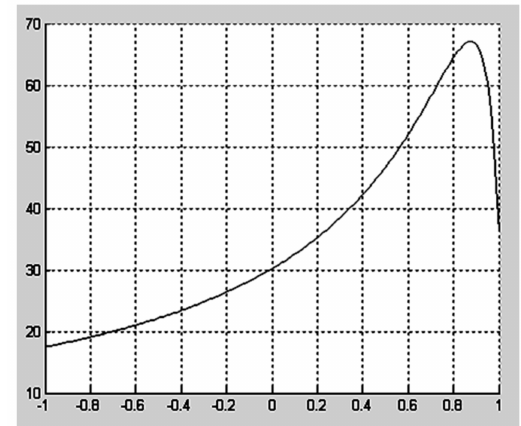
Figure 6. Equal strength operating device profile